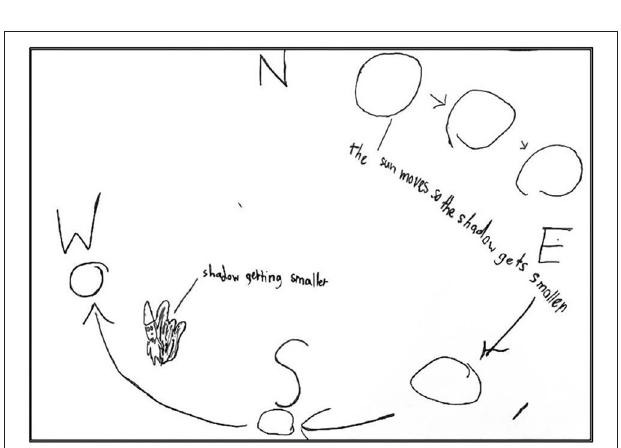
FIGURE 6 | Noel’s drawing of the sun’s movement related to shadow size and direction.